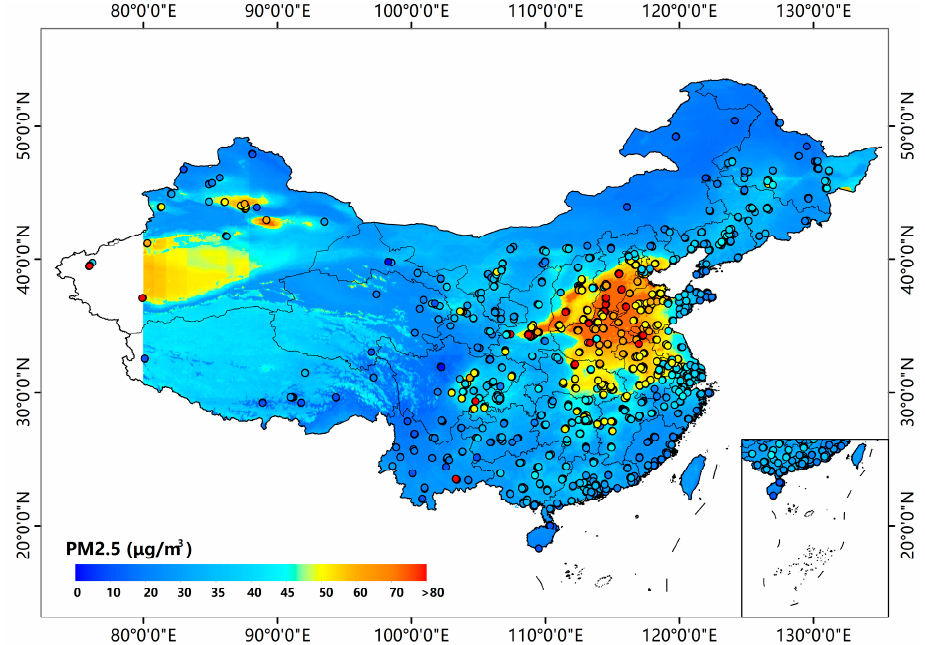
Figure 6. AOD H+M -derived annual PM 2.5 concentrations and measurements of monitoring sites.